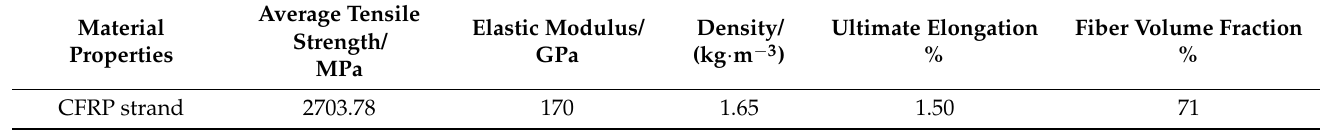
Figure 1. Cross-sectional dimensions of CFRP strands for testing. ( a ) CFRP strand section; ( b ) CFRP strand for testing. Table 1. CFRP strand material properties.